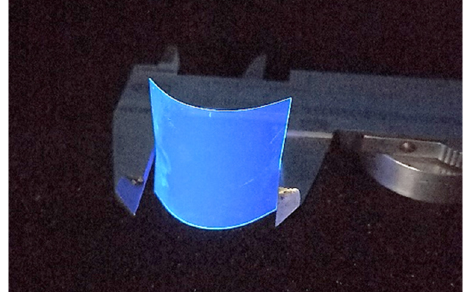
Figure 2. A 30 × 40 × 0.1 mm 3 thin-film flexible PEN scintillator illuminated with UV light.